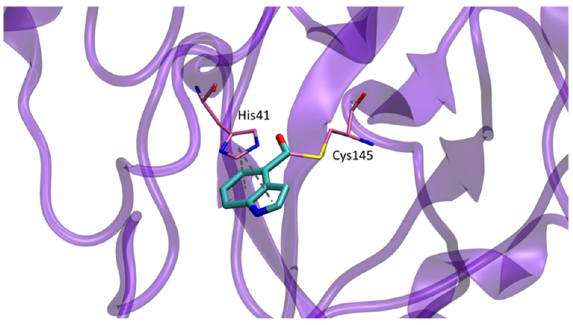
Figure 14. Detail of crystal structure of Mpro ‐ 9d complex.